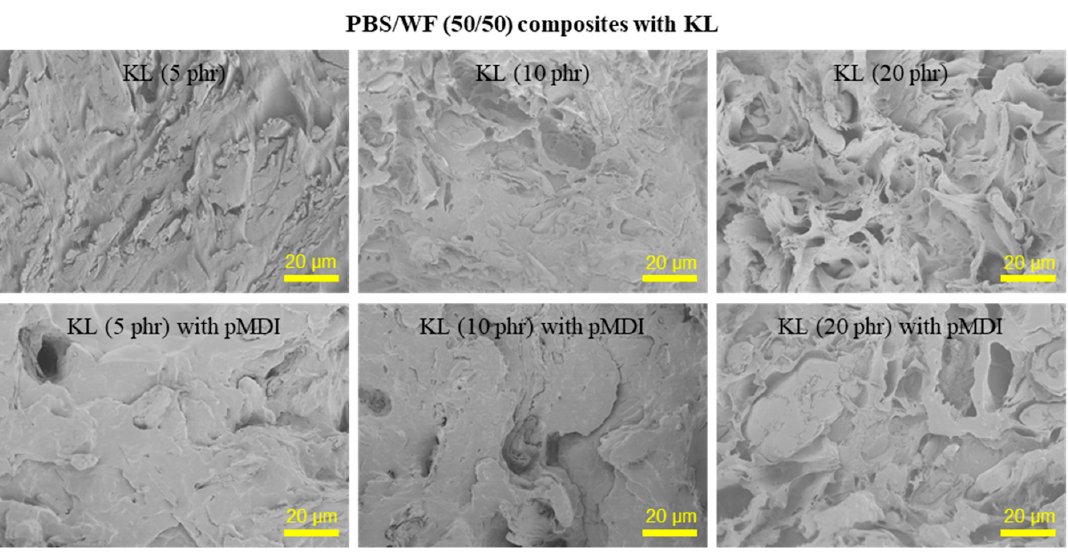
Figure 3. SEM micrographs of the fractured surface of PBS/WF (50/50) composites with varying KL contents with and without pMDI (2